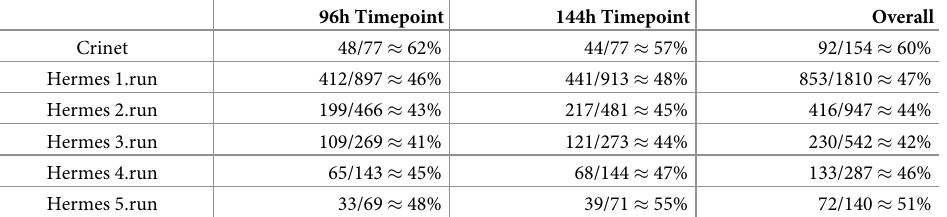
knockdown experiment in breast cancer cell line. Based on the ratios of gene expression fold-change following the knockdown of its ceRNA partners to following the genes that are not its ceRNA partners for each